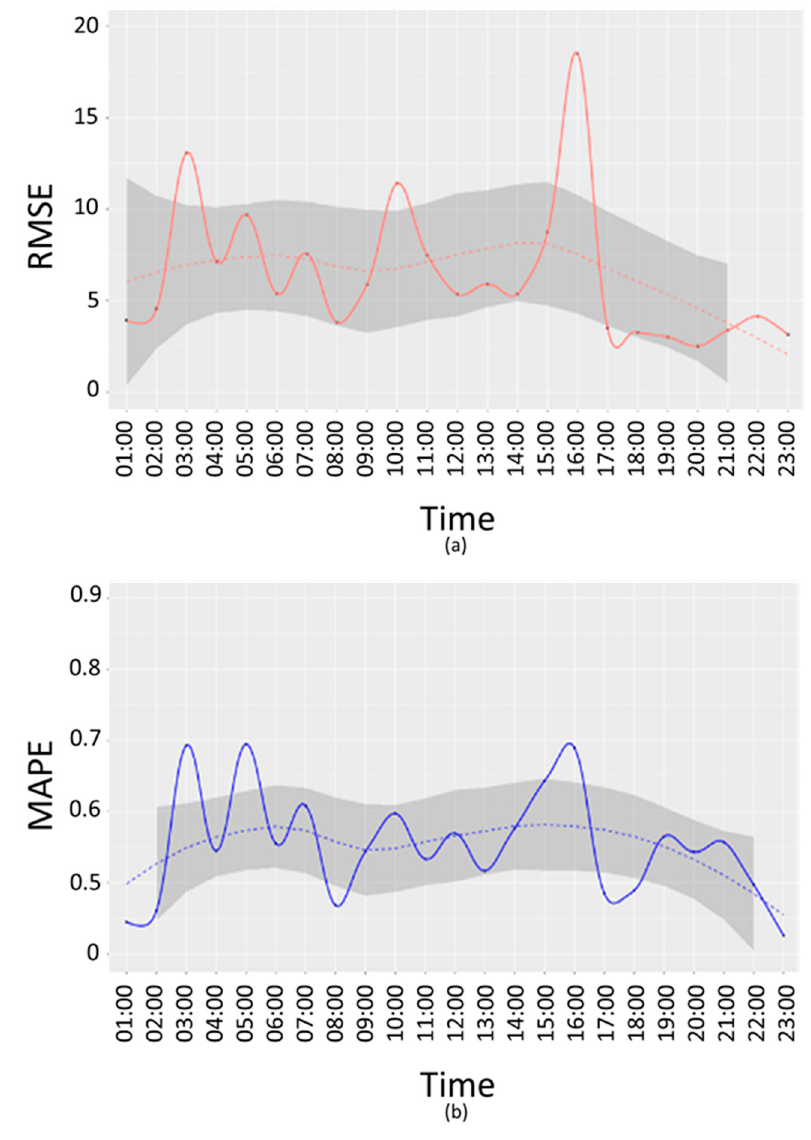
Figure 8. PM 10 working days root mean squared error (RMSE) ( a ) and mean absolute percentage error (MAPE) ( b ) per time slot (Akima Method).